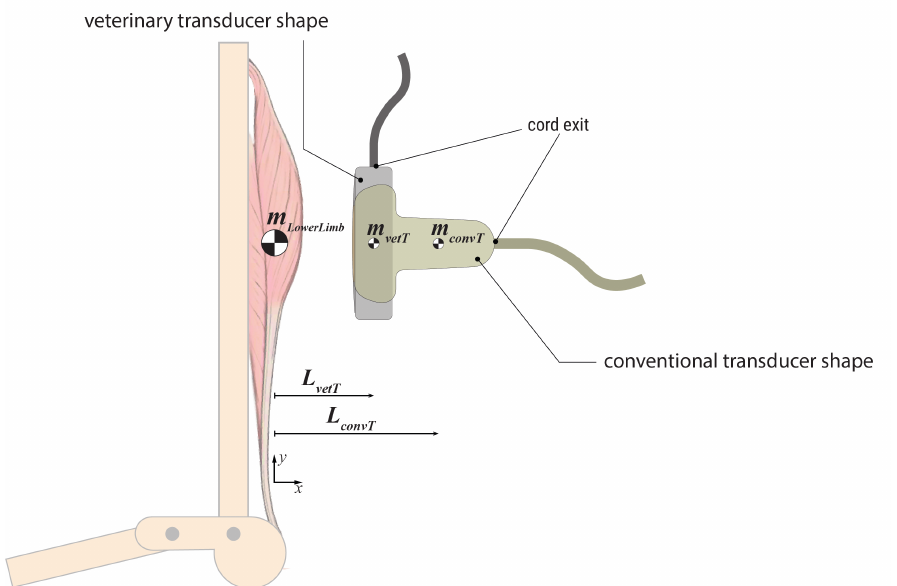
Figure 2. Transducer form factors and their influence on image quality: To build less-interfering setups and reduce imaging bias caused by momentum on the probe head, the lever arm between the centers-of-mass (CM) of moving body parts ( m LowerLimb ) and ultrasound transducer probes ( m vetT –CM veterinary transducer, m convT –CM conventional transducer) should be as small as possible. Veterinary transducers have shorter lever arms ( L vetT ) than conventional probes ( L convT